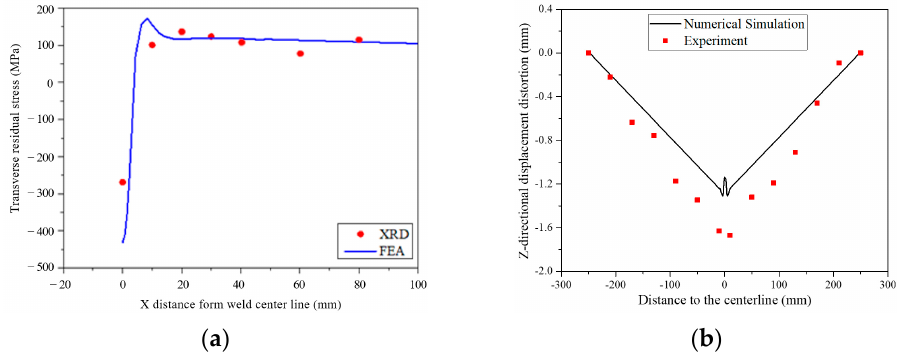
Figure 10. Validation of the experiment data and numerical simulation for: ( a ) transverse residual stress and ( b ) Z-directional displacement distribution.